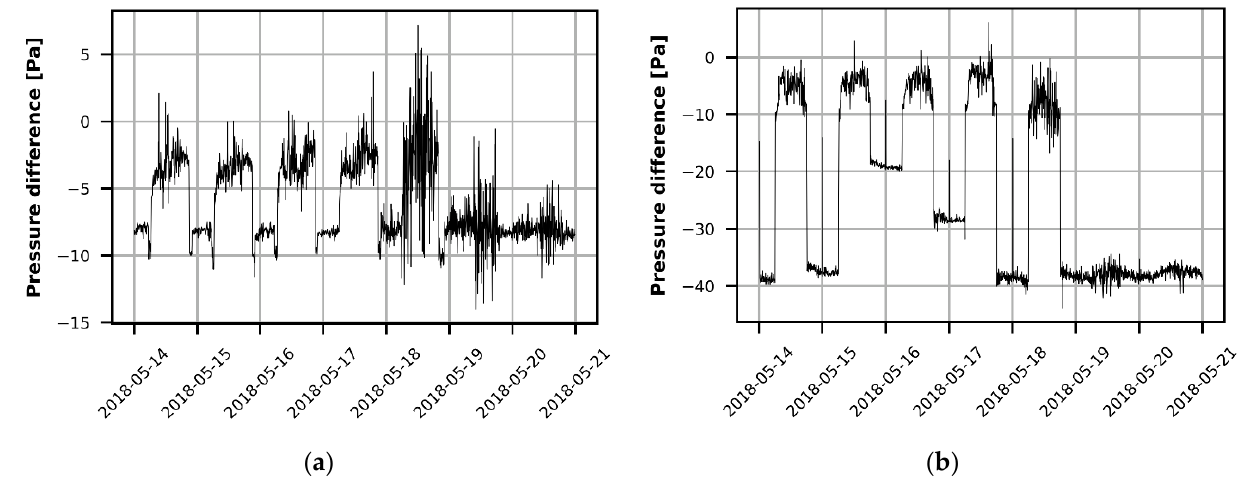
Figure 2. Examples of regularly varying air pressure differences between 14 and 21 May 2018. Air pressure differences were strongly controlled by the mechanical ventilation. Typically, the air pressure difference was smaller (closer to zero) during daytime and larger during weeknights and weekends. ( a ) Small underpressure with steady pattern; ( b ) large underpressure during weeknights and weekends with changing pattern during weeknights.